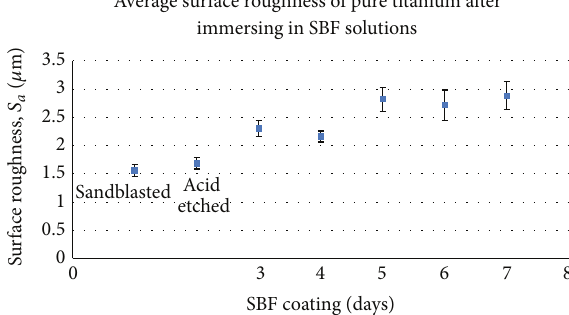
Figure 1: Graph showing 𝑆 𝑎 values of the CPTi samples at various stages and times during the experiment.